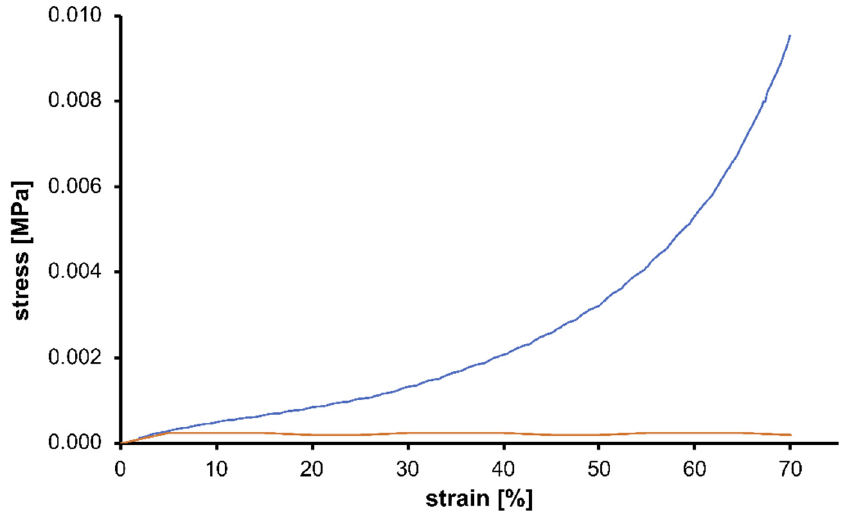
Figure 4. Compressive stress-strain curve for the lyophilized GO-CS aerogel (blue line) compared with the same sample obtained without GO (red line).